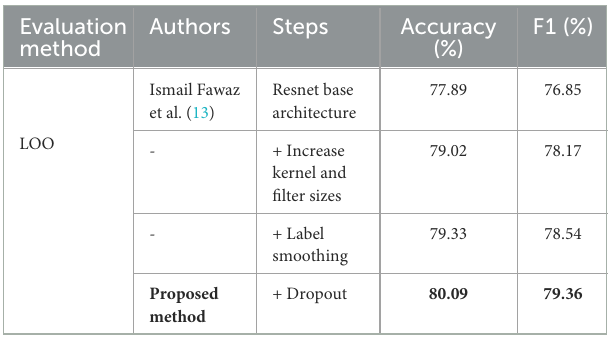
TABLE 6 Simple ablation study on multi-class classification with LOO evaluation for the optimized Resnet.